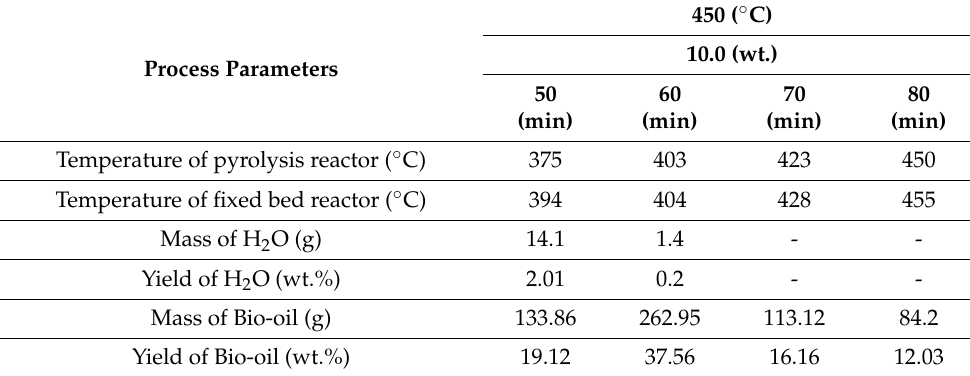
Table 7. Process parameters, mass balances, and partial yields of bio-oil and H 2 O obtained during course of reaction (50–80 min) of experiment using 10.0% catalyst.